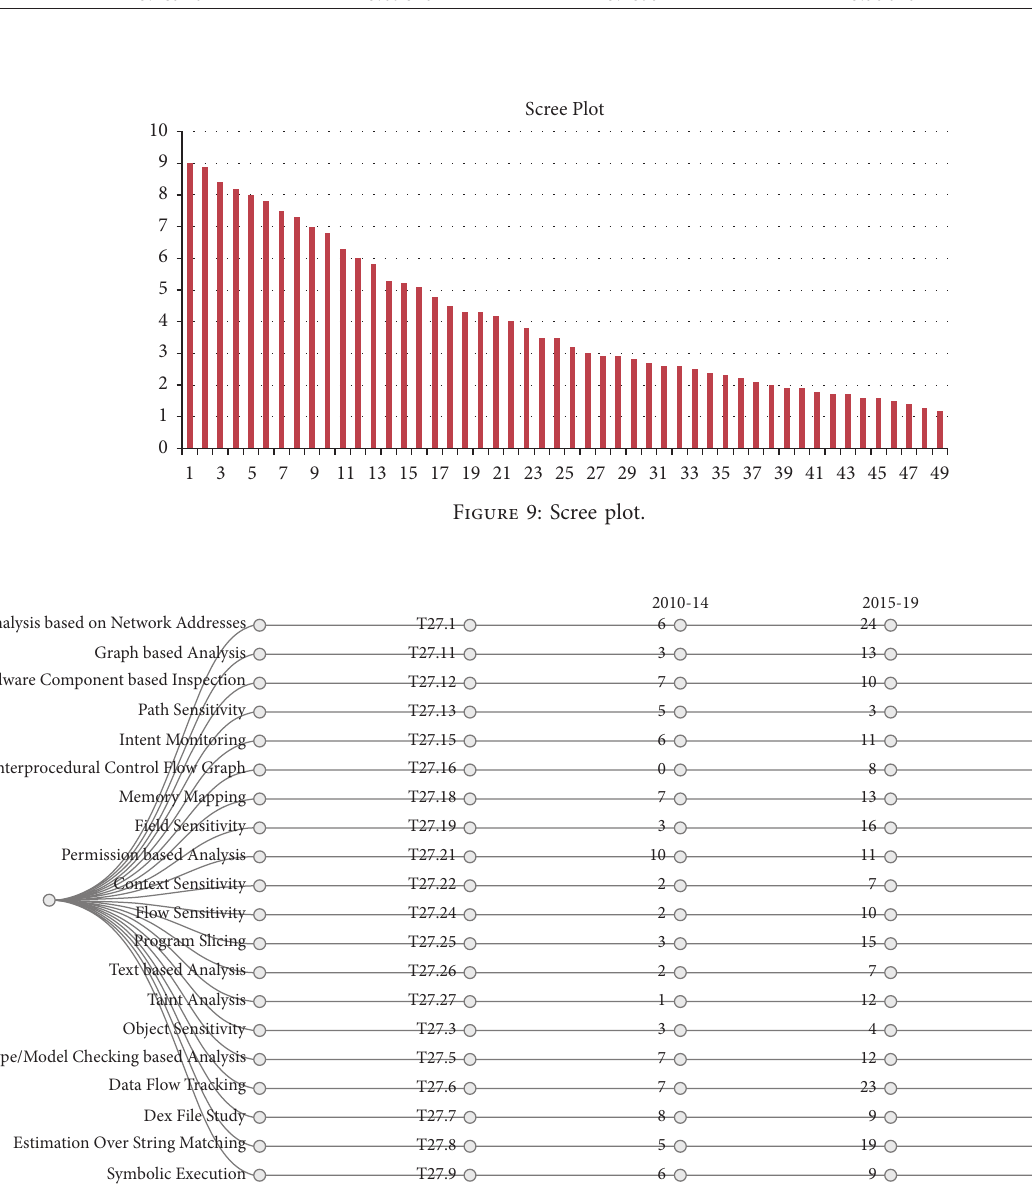
Figure 10: Mapping of core research area 3.2 and